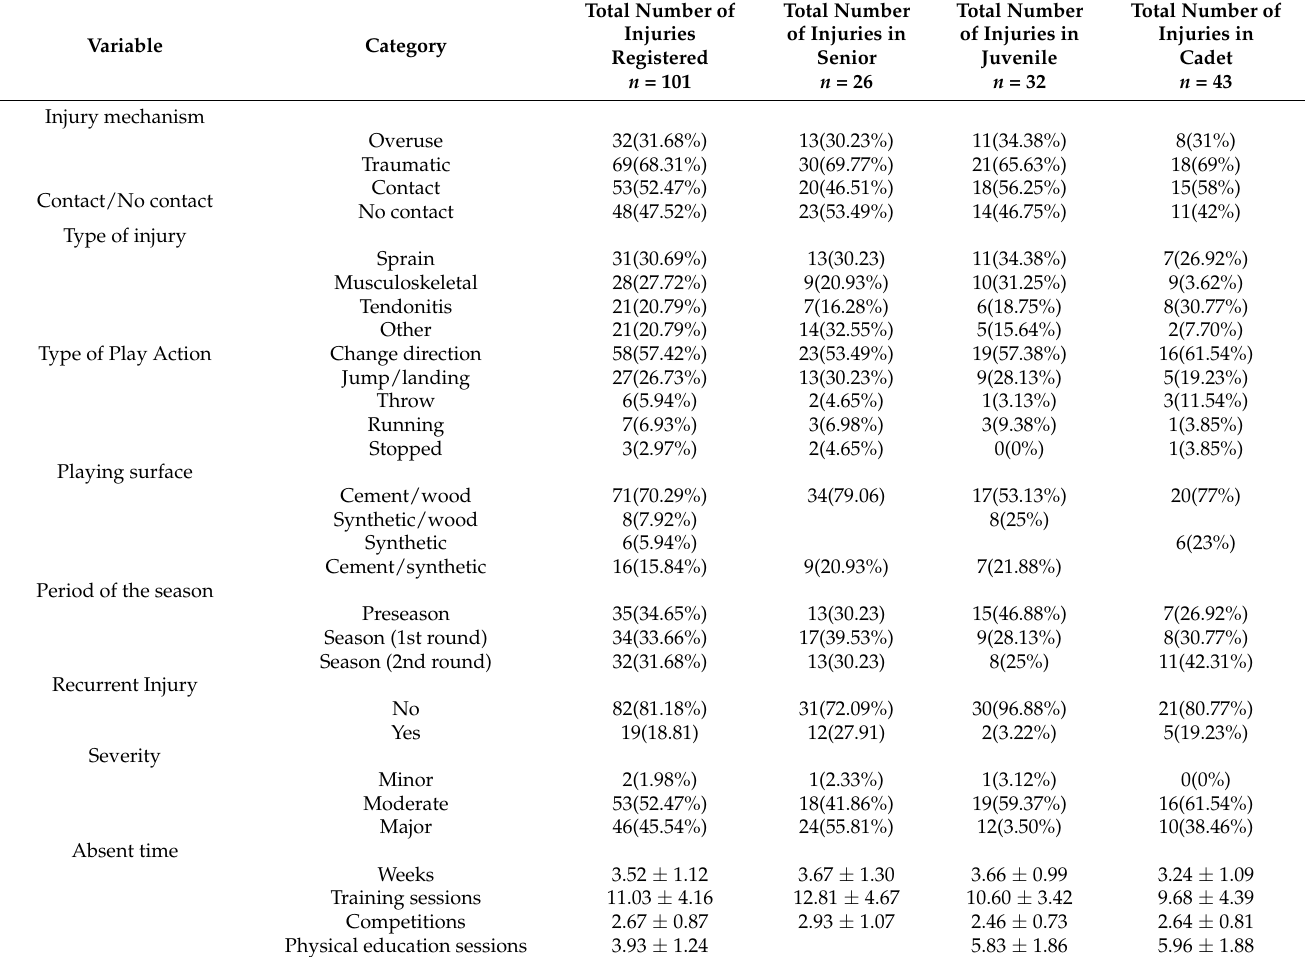
Table 2. Characteristics of the injuries registered in total and by category.